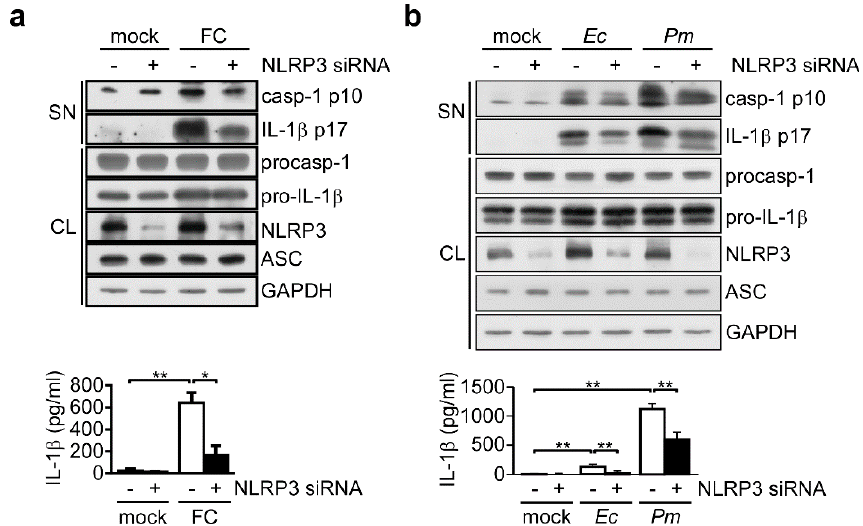
Figure 1. Requirement of the NLRP3 inflammasome for commensal bacteria-induced IL-1 β secondsretion. ( a , b ) Top panels: Immunoblot analysis of NLRP3 inflammasome molecules in cell supernatants (SN) and cell lysates (CL). Bottom panels: ELISA of IL-1 β in the SN of THP-1-derived macrophages treated with NLRP3 siRNA and then incubated for 3 h with ( a ) fecal content (FC), ( b ) E. coli ( Ec ) or P . mirabilis ( Pm ). The western blot is a representative of three independent experiments. ELISA data were analyzed with the ANOVA test followed by post hoc test. *, p < 0.05; and **, p < 0.01. All results are presented as the mean ± SD of three independent experiments. Abbreviations: casp-1 p10, active caspase-1 subunits; IL-1 β p17, secondsreted mature IL-1 β ; procasp-1, p45 precursor of caspase-1; and pro-IL-1 β , p31 precursor of IL-1 β